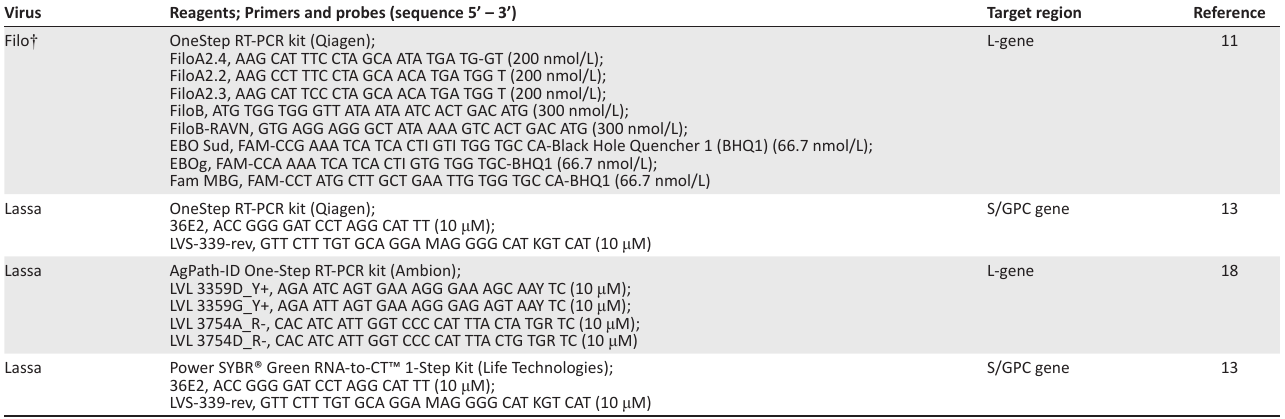
TABLE 1: Reverse transcription-PCR test assays used in the laboratory investigations, Ghana, 2013. Virus Reagents; Primers and probes (sequence 5’ – 3’) Filo